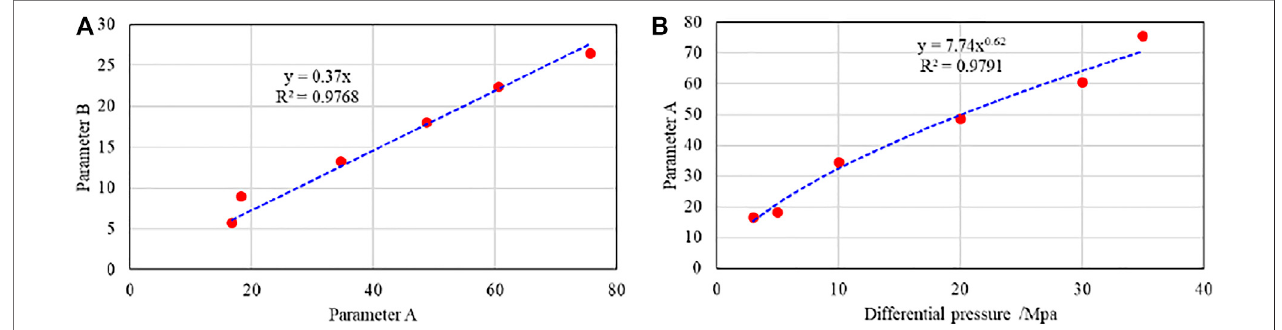
Frontiers in Energy Research |